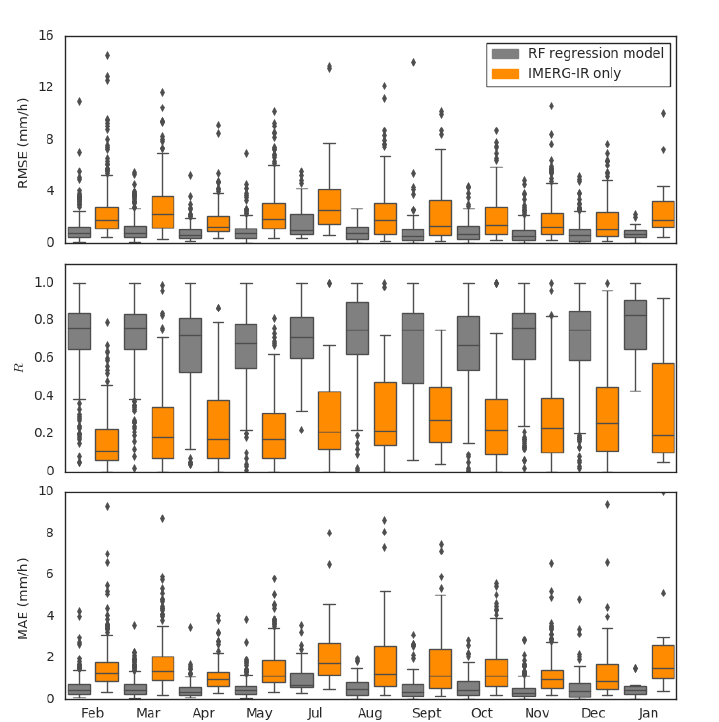
Figure 8. Standard validation scores for RF regression model (rain rate). The scores were calculated on a scene-by-scene basis. Boxes show 25th, 50th, and 75th percentiles. Whiskers extend to the most extreme data point between 75th and 25th percentile. Outliers are shown as